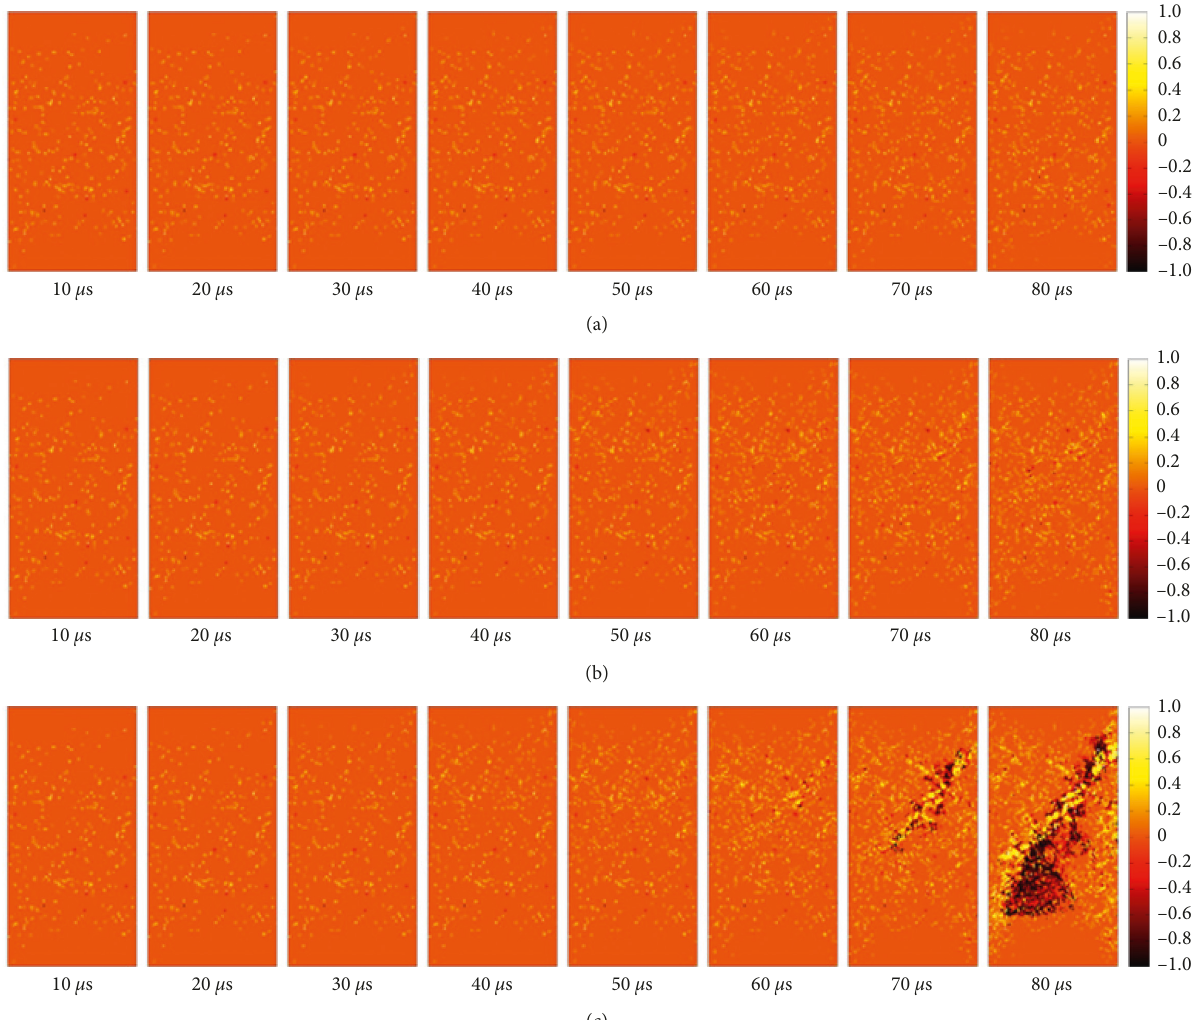
Figure 11: The creep failure process of rock specimen triggered by dynamic disturbance: (a) impact load I ( p � 20MPa); (c) impact load III ( p II ( p dmax